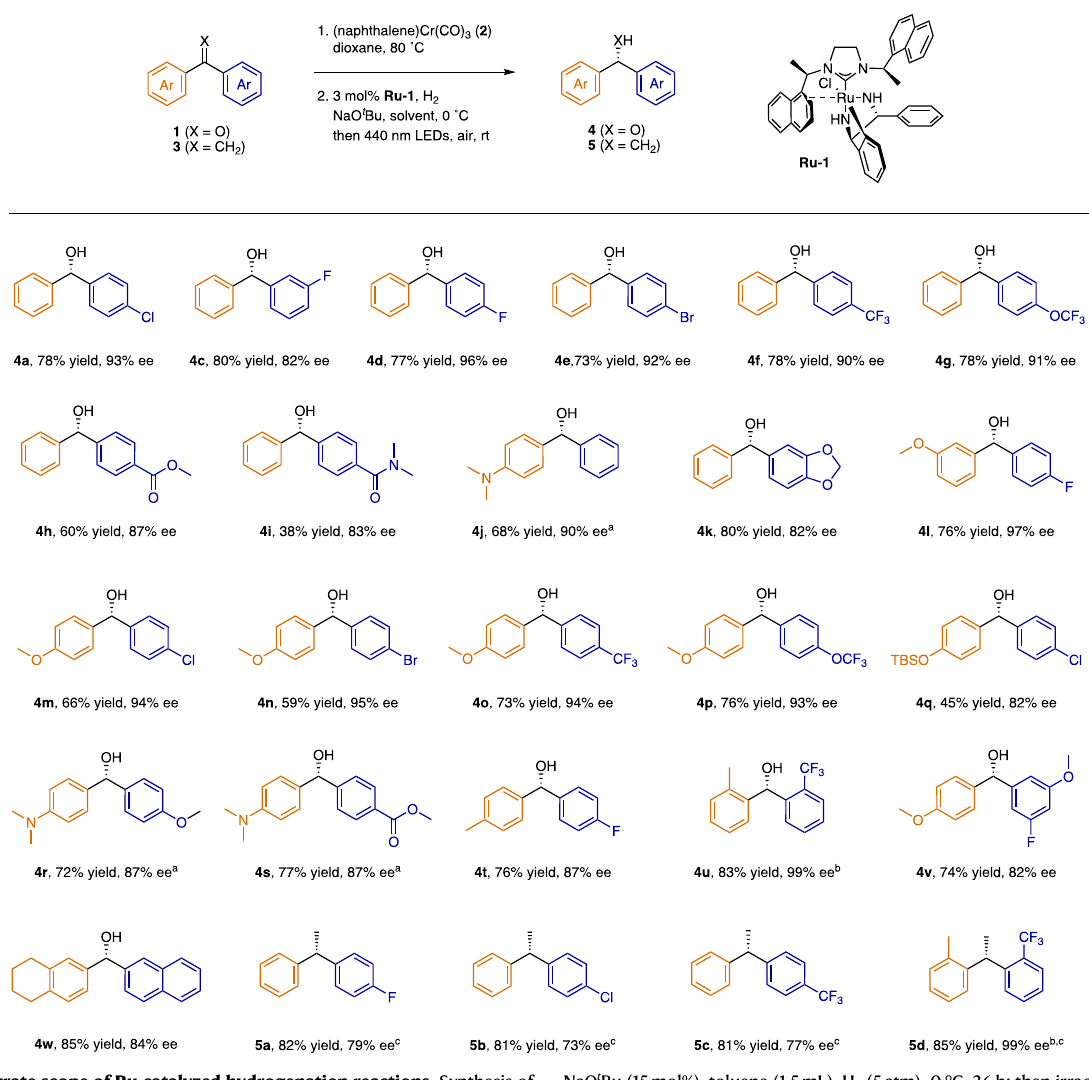
NaO t Bu (15mol%), toluene (1.5mL), H 2 (5atm), 0°C, 36h; then irradiation with 440nm LEDs for 2h in air at room temperature. a (1) 2 (0.22mmol). b (2) Room temperature. c (2) Hexane (1.5mL), H 2 (50atm). Isolated yields were reported. The absolute con fi gurations of 4a , 4e , 4h , and 4m were S , as determined by compar- ison of their optical rotations with reported